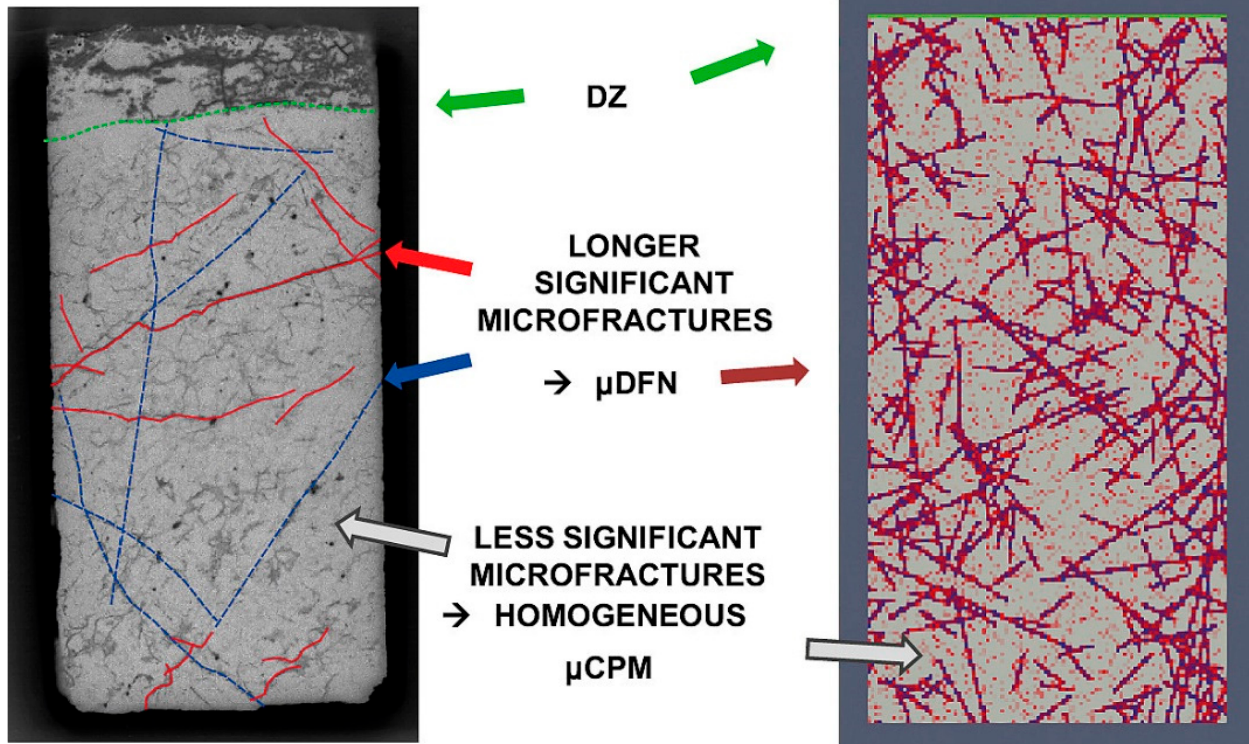
Figure 5. Definition of the basic components of the rock matrix; Disturbed Zone (DZ, which is indicated by green arrows and lines), longer significant micro-fractures, and less significant micro-fractures forming the background of the image. Rock matrix microscope photograph on the left and a micro-continuum model with a randomly generated network of micro-fractures in the cross-section on the right (after [22]).